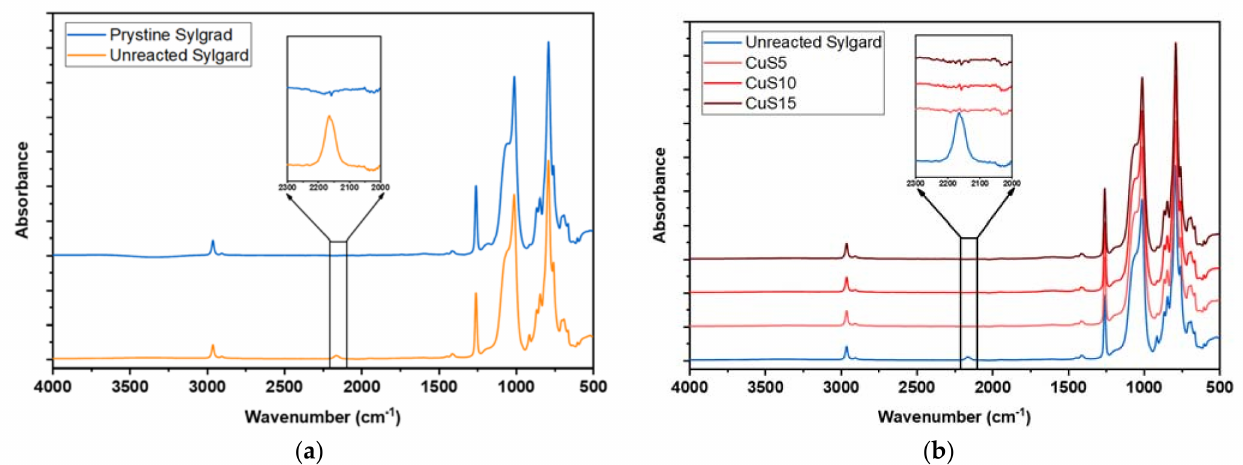
Figure 1. ART-FTIR spectra; ( a ) spectra of Sylgard pristine formulation (Entry 1; Table 1) before (orange curve) and after (blue curve) thermal curing at 150 ◦ C. zoom of the Si-H peak at 2160 cm − 1 in the insert of the graph; ( b ) spectra filled Sylgard formulation containing spheroidal Cu (Entry 2, 3, 4; Table 1), before (blue curve) and after (red curves) thermal curing at 150 ◦ C. Zoom of the Si-H peak at 2160 cm − 1 in the insert of the